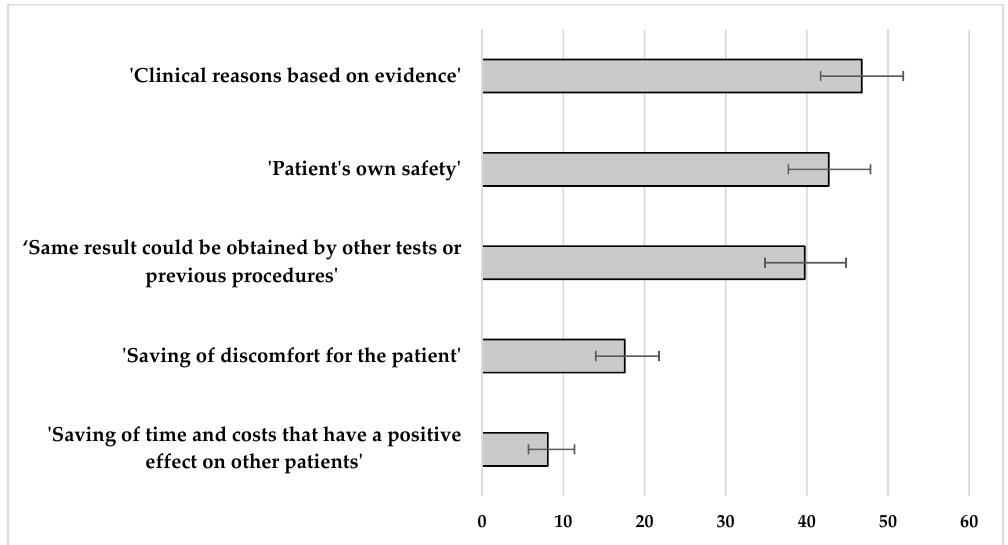
Figure 4. Arguments considered “highly effective” or “very highly effective” to persuade the patient about the inadequacy of medical procedures. Percentage of professionals who indicated each reason (with the expected 95% confidence interval of such percentages).